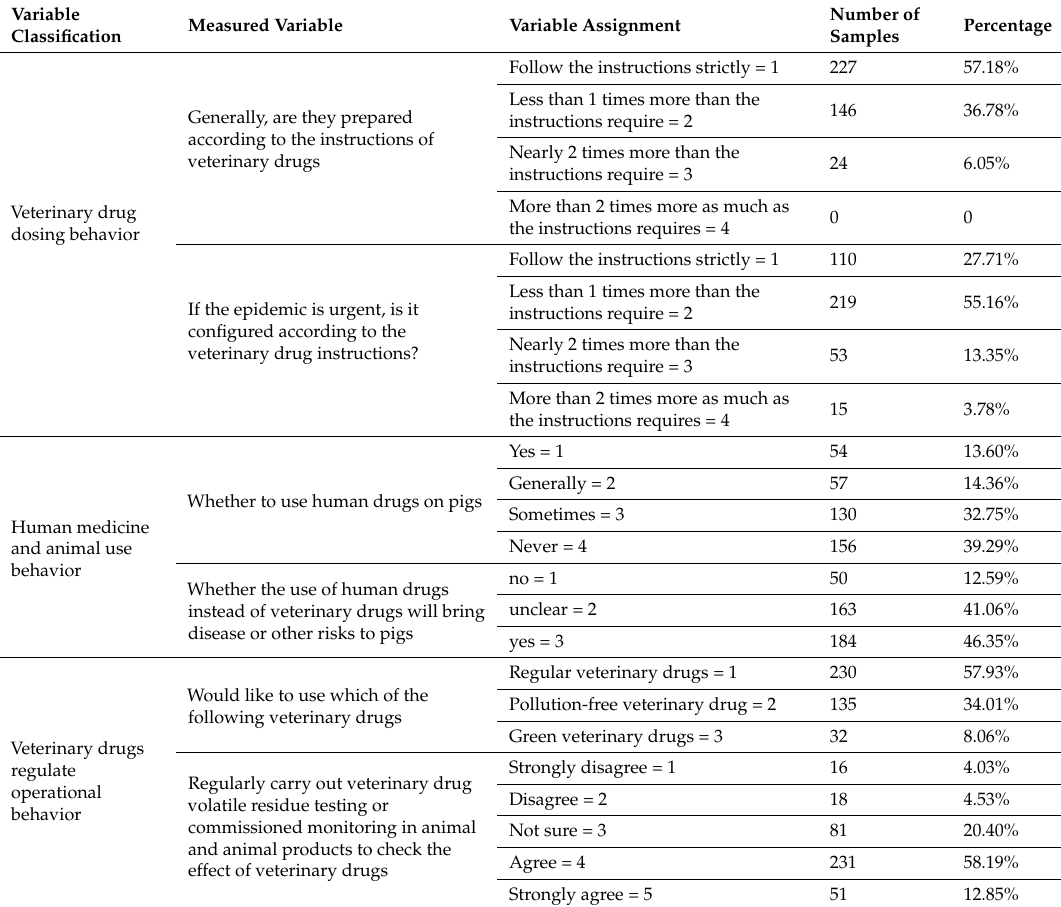
Table 2. Descriptive statistics of the interpreted